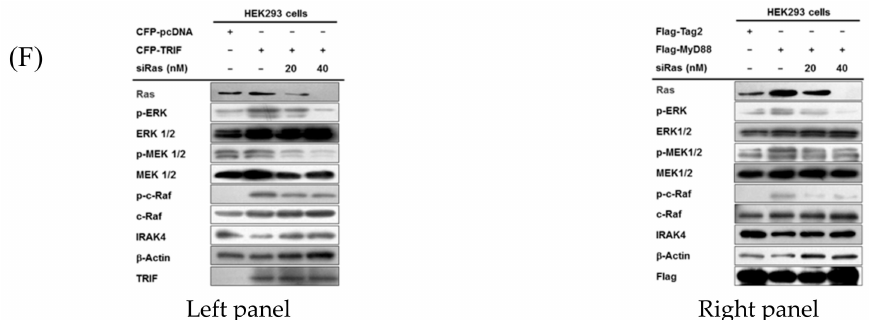
Figure 5. ICMT / Ras expression is both MyD88- and TRIF-dependent. (( A ), upper panel) Protein levels of MyD88 and TRIF in RAW264.7 cells under their knockout conditions in the presence or absence of LPS (1 µ g / mL). ( A , middle panel) Inhibitory e ff ects of MyD88 and TRIF knockout on the expression of inflammatory genes ( TNF- α and IL-1 β ) in RAW264.7 cells stimulated with LPS (1 µ g / mL). (( A ), lower panel, ( B , D )) AP-1-mediated luciferase activity was analyzed by reporter gene assay in MyD88- and TRIF-knockout RAW264.7 cells (( A ), lower panel), HEK293 cells transfected with Flag-MyD88 or CFP-TRIF ( B ), or HEK293 cells transfected with Flag-MyD88 or CFP-TRIF in the presence or absence of siICMT or ICMT-E167A (( C ), left and right panels). Luminescence levels were determined with a luminometer. ( D ) mRNA expression levels of COX-2 , TNF- α , and IL-1 β were determined using real-time PCR in HEK293 cells transfected with MyD88 (( D ), left panel) or TRIF (( D ), right panel). ( E ) Total and phospho-protein levels of MAPK in HEK293 cells during transfection with MyD88 , TRIF , and the dominant negative form of ICMT ( ICMT-E167A ). ( F ) Total and phospho-protein levels of ERK1 / 2 and their upstream enzymes (MEK1 / 2, c-Raf, and IRAK4) in HEK293 cells transfected with MyD88 or TRIF in the presence or absence of siRas were analyzed using immunoblotting